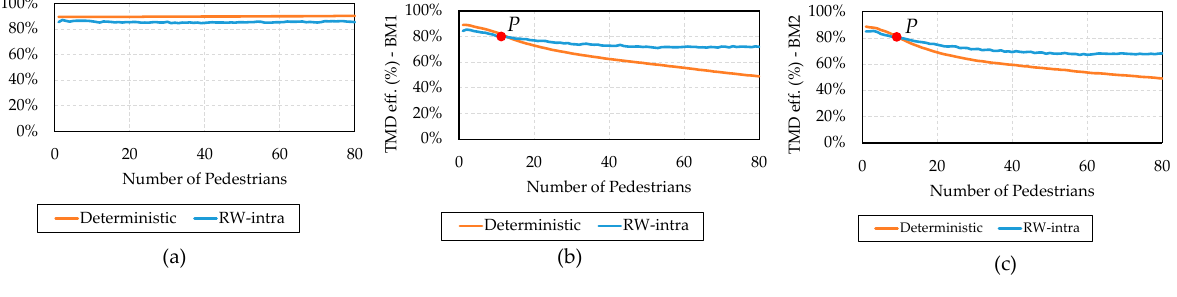
Figure 6. TMD efficiency for the deterministic and RW-intra responses. ( a ) FM, ( b ) BM1, and ( c ) BM2. The TMD efficiency differences are more remarkable in the BM models. For few pedestrians, the RW-intra responses presented a lower TMD efficiency. After a certain point P , highlighted in Figure 6b,c, the deterministic TMD efficiency became lower